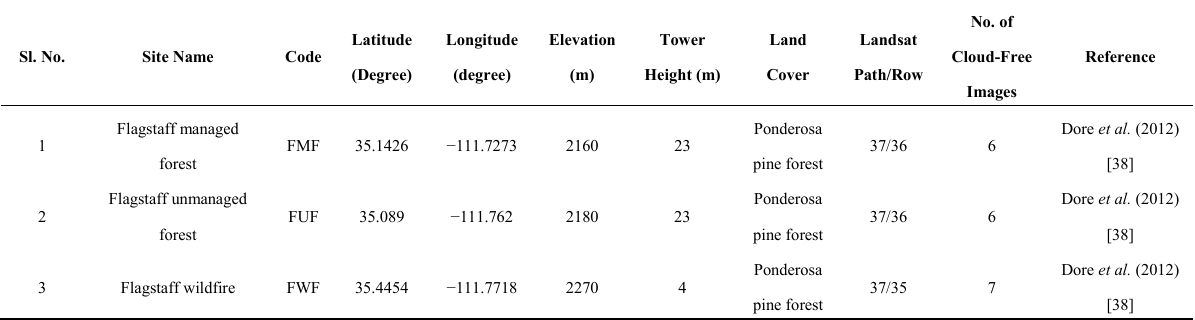
Table 2. Details of eddy covariance tower validation sites used in this study. Sl.